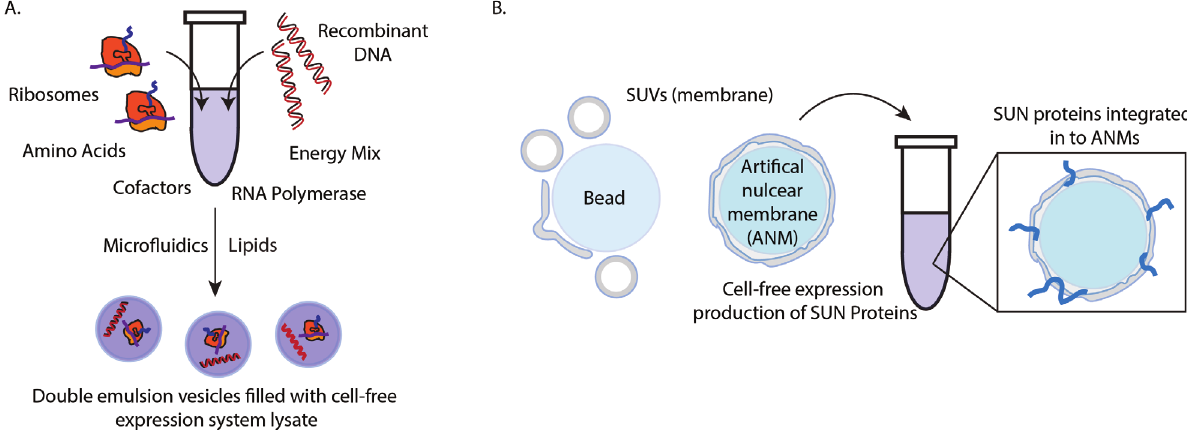
Figure 2: Bottom-up synthetic biology approaches to study biology. A. Cell-free expression system schematic. Cell lysate is collected from a desired cell type – bacterial or mammalian – and supplemented amino acids, energy mix (NTPs), cofactors, salts, RNA polymerase, and your desired cell-free expression system compatible plasmid. Incubation a specified temperature results in the production of the desired protein (encoded by the plasmid). Experiments can be conducted in bulk or encapsulated within double emulsion vesicles (i.e. liposomes) B. Experimental strategy for the investigation of the SUN1 and SUN2 topology on artificial nuclear membranes. Initially silica beads are incubated with SUVs to generate model artificial nuclear membranes (ANMs). Afterwards, ANMs are incubated with cell-free lysate containing plasmids encoding the SUN1 or SUN2 genes, which upon protein synthesis, leads to the functional reconstitution of the SUN proteins on ANMs. Panel B was adapted from Majumder et al 2018